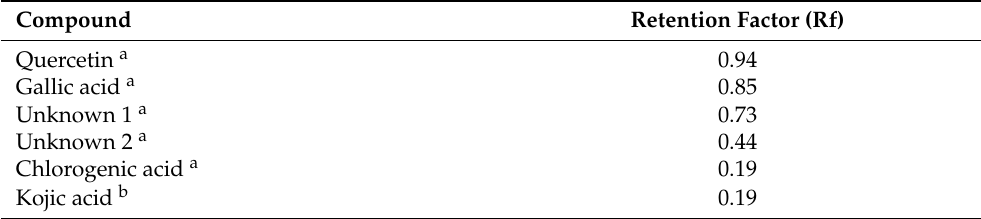
Table 1. Retention factor (Rf) of Athrixia phylicoides metabolites and kojic acid.